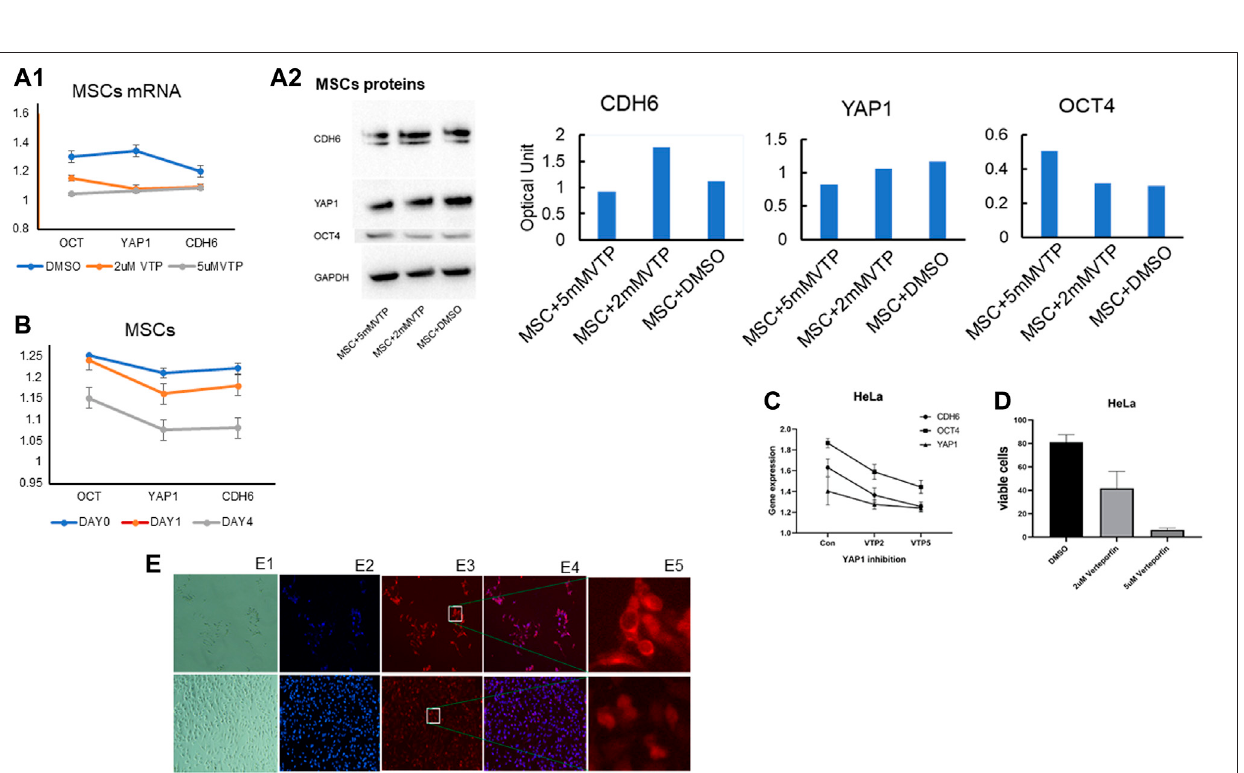
FIGURE 4 | V ertepor fi n signi fi cantly decreases solid tumor cell viability and inhibits YAP1. (A) MSCs were harvested on Day 12 following incubation in a differentiation medium. CDH6, YAP1, and OCT4 transcripts were all signi fi cantly down-regulated by 2 M Vertepor fi n in a time-dependent manner (A1) and the corresponding proteins by Western blotting (Blots are representative of three independent experiments, adjacent to the quanti fi cation of the related proteins) (A2) . Vertepor fi nsigni fi cantlydownregulated (B) TranscriptsforOCT4inadose-dependentmanner(atboth2and5 Mdoses),butnosigni fi cantchangeswereobserved for YAP1 or CDH6 [Note that all gene expression levels are indicated expression levels relative to the untreated controls]. (C) Transcripts for CDH6 and OCT4 by PCR were signi fi cantly decreased in tumor cells by 2 M vertepor fi n compared to controls, but no signi fi cant differences were observed for YAP1. [All the above qPCR results werenormalized against betaactin]. (D) HeLacellswereincubated in2and 5 Mconcentrationsofvertepor fi n for24 hand harvested.Thetrypan bluedye exclusion test was used to assess the viability of cells cultured with and without vertepor fi n. Cells were counted under a hemocytometer. Cell viability in both cancer cell lines was inverselycorrelatedtoincreasingdosesofvertepor fi n.Cellviabilitywassigni fi cantlydecreased( p < 0.05)with2and5 Mconcentrationsofvertepor fi nwhencomparedto controls across both cell lines. (E) Effects of YAP1 inhibitor vertepor fi n on HeLa cells after 24 h incubation. Top panels E1 to E5: (E1) Bright- fi eld image; (E2) NucBlue staining for live cells; (E3) YAP1 fl uorescent staining; (E4) merged NucBlue (blue) and YAP1 antibody staining (red). (E5) Images with higher magni fi cation show the location of YAP1. Lower panels of the E1 to E5 are the corresponding controls showing cells cultured with DMSO. Vertepor fi n administered at 2uM in cell culture substantially reduced the number of viable cells compared to DMSO controls. Vertepor fi n signi fi cantly reduced YAP nuclear localization, and cells cultured with DMSO showed YAP1 staining mostly localizing to the nucleus and staining overlapped with NucBlue.